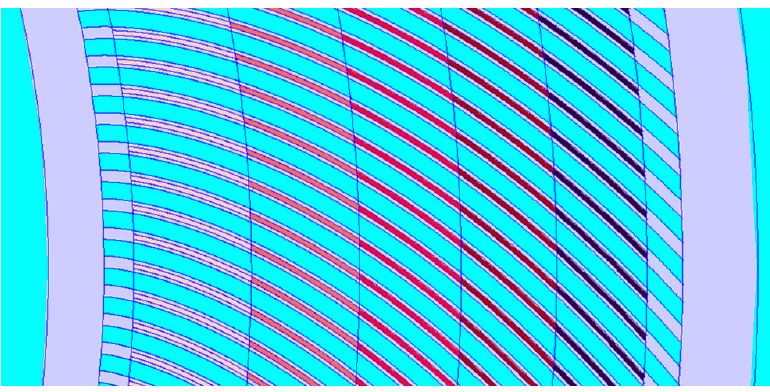
Figure 8. Partial representation of the annular core section of the RHF reactor by Silène.